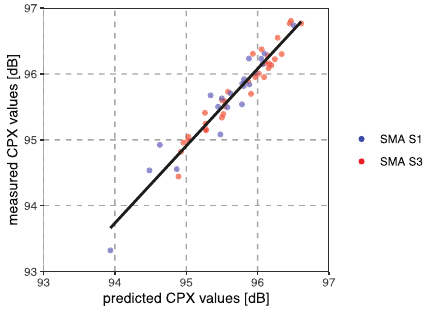
Figure 17. Reevaluation of the combined overall random forest CPX model based on the fi nal model prediction. The black line shows the linear regression model of the